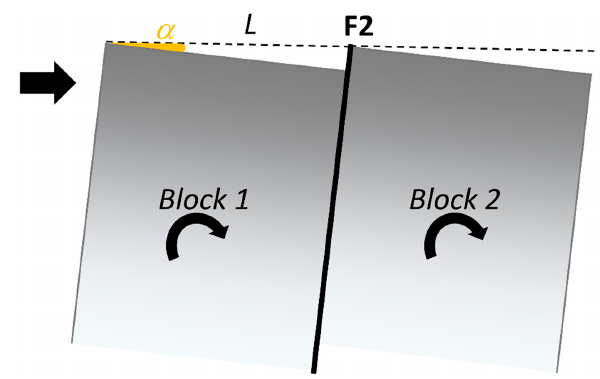
Figure 8. Schematic interpretation of the movement of F2.